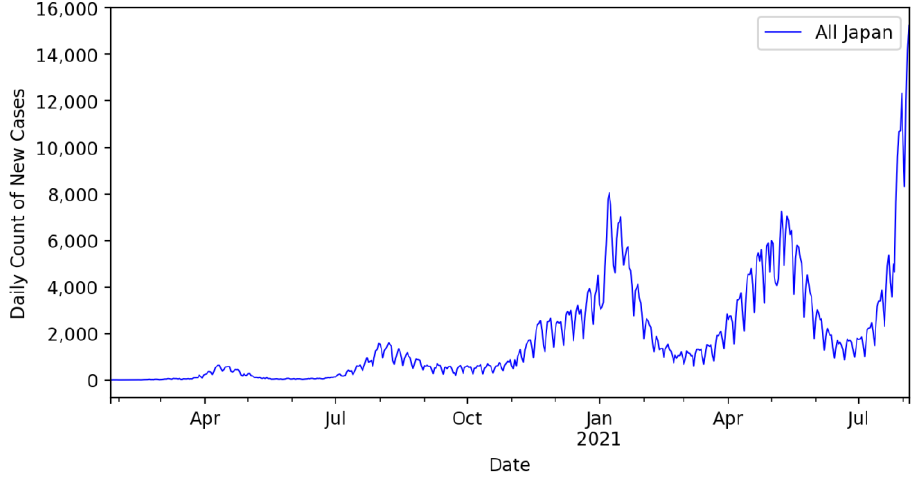
Figure 3. Daily confirmed cased of COVID-19 in Japan from January 2020 to July 2021.